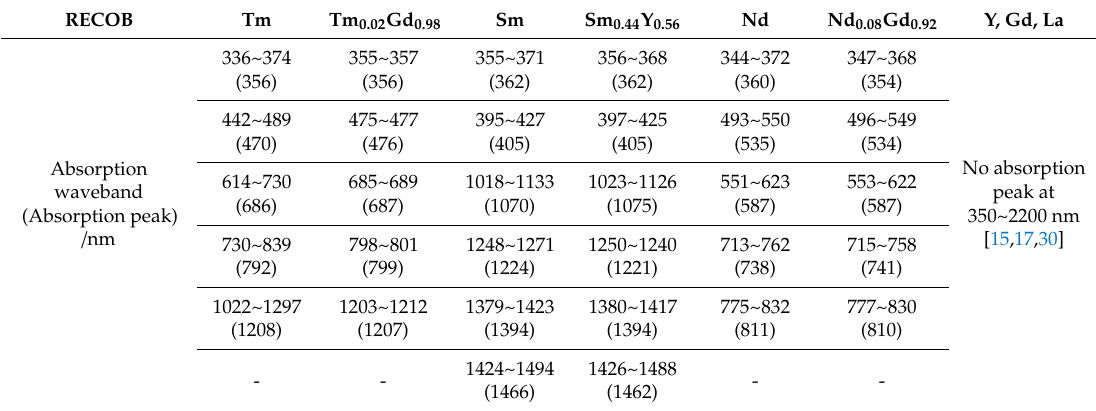
Table 3. Absorption properties of RECOB (RE: Tm, Tm 0.02 Gd 0.98 , Sm, Sm 0.44 Y 0.56 , Nd, Nd 0.08 Gd 0.92 , Y, Gd, and La)